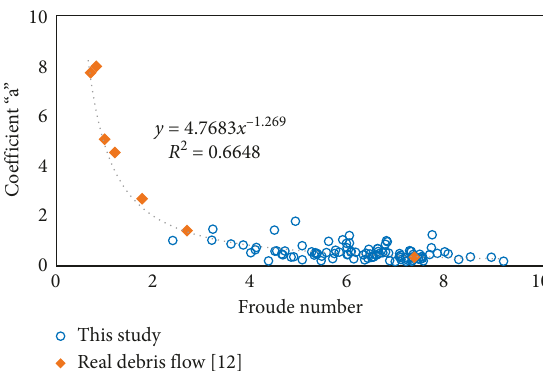
Figure 5: The relationship between the coefficient of hydrodynamic model for impact force and Froude number. Blue circles show the results of this experiment, and orange diamonds represent data of real debris flow